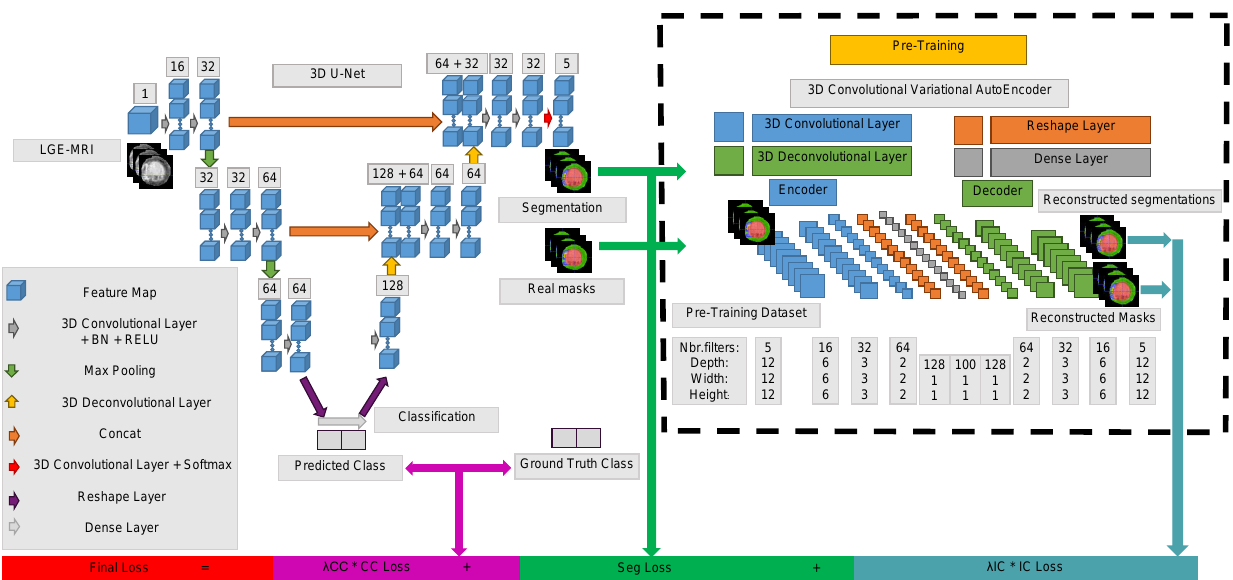
Figure 4. The overall architecture of our pathological segmentation network. We present the number of channels overhead each feature map. The classification is as well applied only in the training stage to supervise the segmentation network